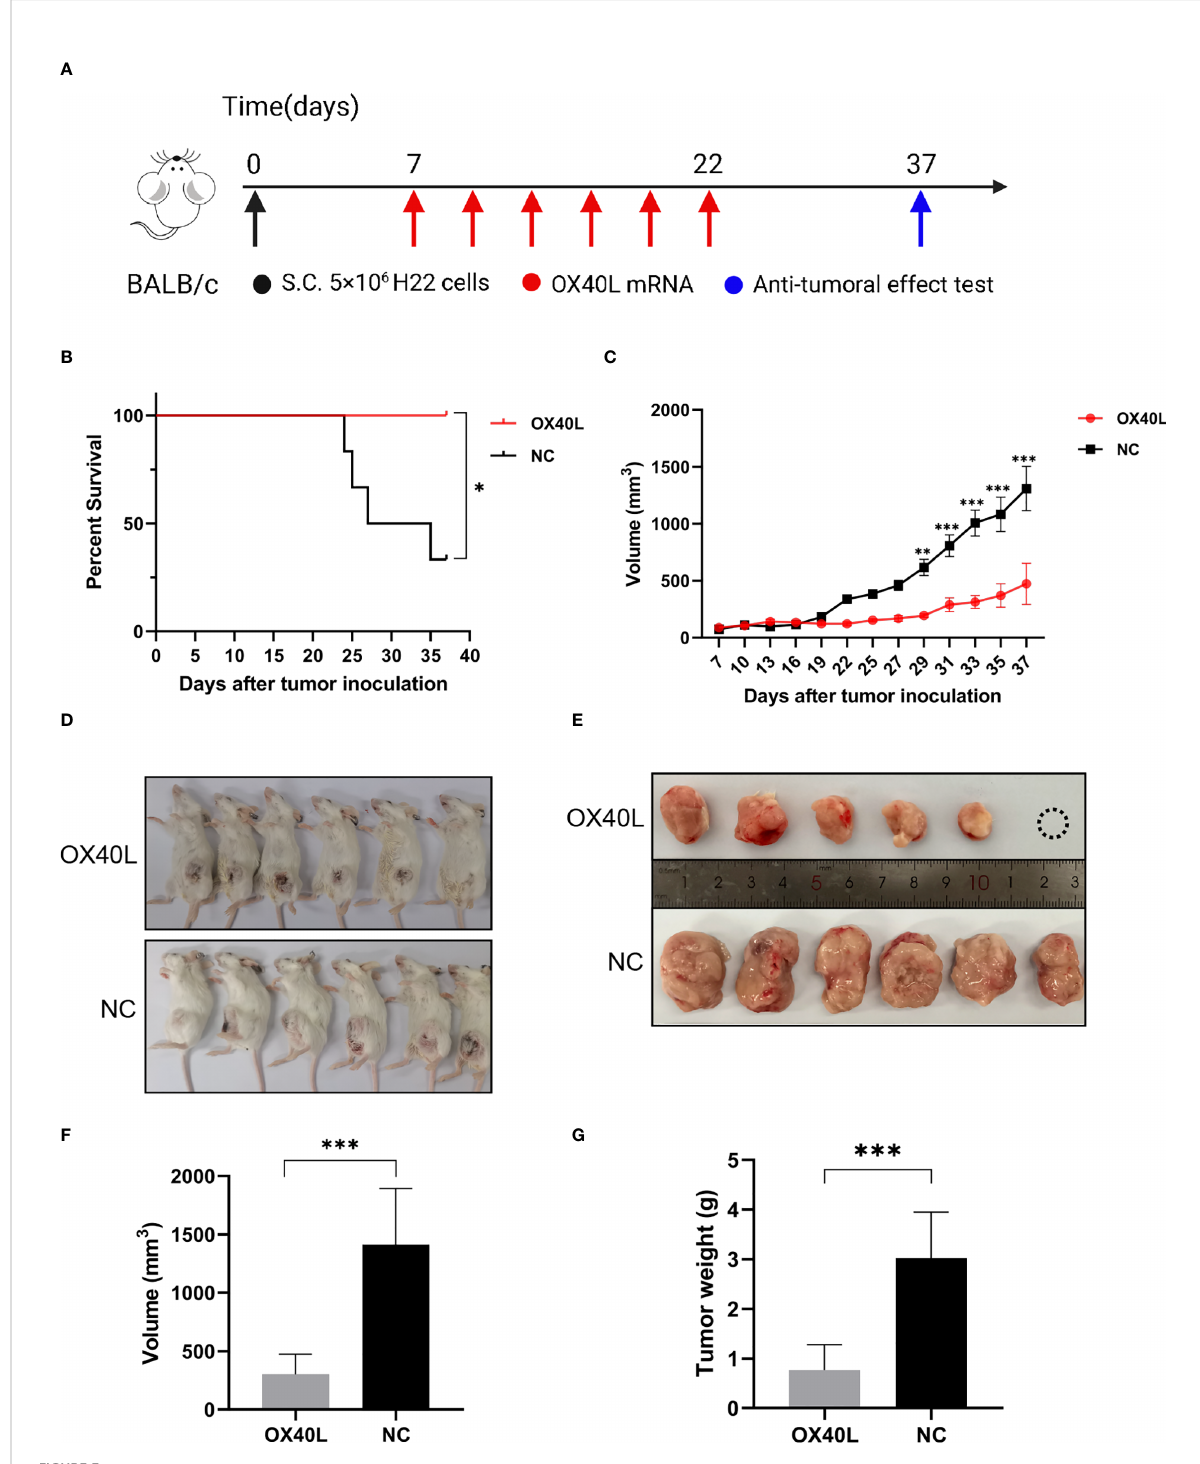
FIGURE 3 In vivo ef fi cacy of intratumoral therapy with OX40L mRNA. (A) Timeline for treatment of H22 tumor-bearing mice. (B) Kaplan-Meier analysis of mouse survival after treatment with OX40L-mRNA and non-coding mRNA; log-rank test, p =0.0183. (C) Growth of subcutaneous tumors growth curves (median ± interquartile range [IQR]) of each group treated with OX40L-mRNA and the control. Two-way repeated-measures ANOVA using the Sidak multiple-comparisons test, ** p ≤ 0.01, *** p ≤ 0.001, compared to non-coding mRNA. (D) Images of mice from the two groups at day 37. (E) Tumors; white circle, no tumor. (F) Tumor volume at day 37. Statistical signi fi cance was calculated via t test. *** p ≤ 0.001. (G) Tumor weight at day 37. Statistical signi fi cance was calculated via t test. *** p ≤